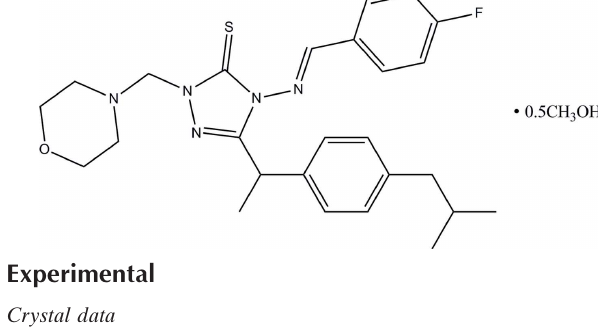
Bruker APEXII DUO CCD area- detector diffractometer